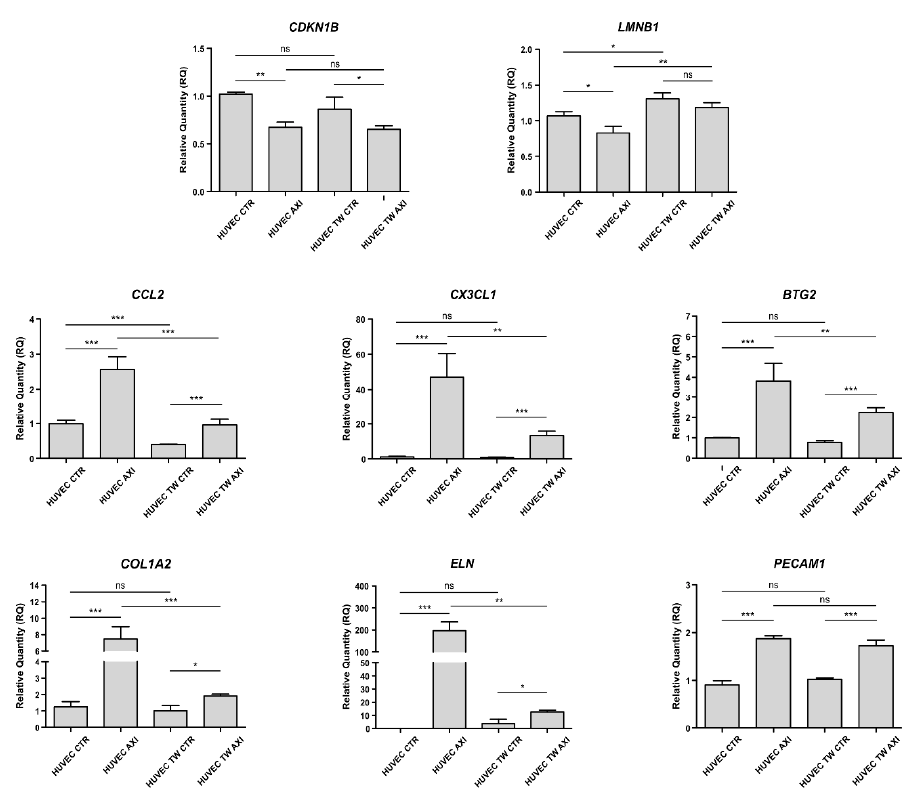
Figure 5. Axitinib- dependent modulation of HUVEC gene expression was altered by GBM coculture. Real-time PCR was performed on RNA extracted from HUVECs cultured alone or in transwell with U87MG, three days after Axitinib pulse. Senescence-related genes (CDKN1B and LMNB1), SASP genes (CCL2 and CX3CL1), extracellular matrix genes (COL1A2 and ELN), and an endothelial cell marker (PECAM1) expression were analyzed. Except for PECAM1, Axitinib-dependent mRNA modulation appeared altered in coculture system. Relative quantities were calculated normalizing for TBP and are given relative to control HUVECs (sham-treated). Mean values and standard deviation were generated from at least three biological replicates.* p value < 0.05; ** p value < 0.01; *** p value < 0.001.